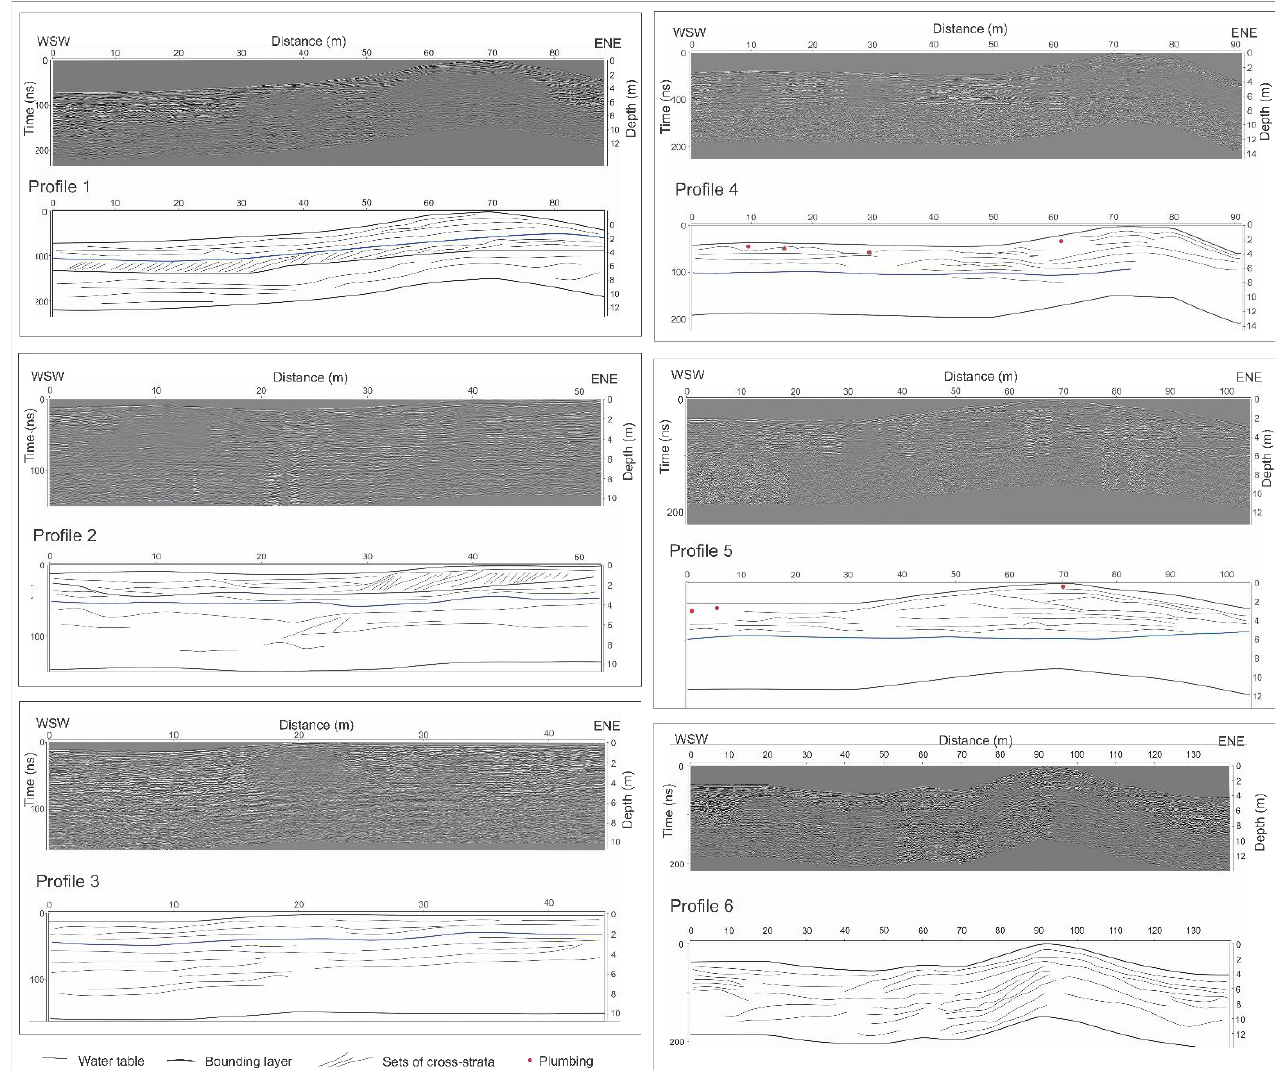
Figure 12. GPR sections processed and interpreted from profiles P1, P2, P3, P4, P5 and P6 (See the location of profiles in Figure 3). Wind direction from ENE to WSW, from the right to the left of the images. Cumbuco Beach.